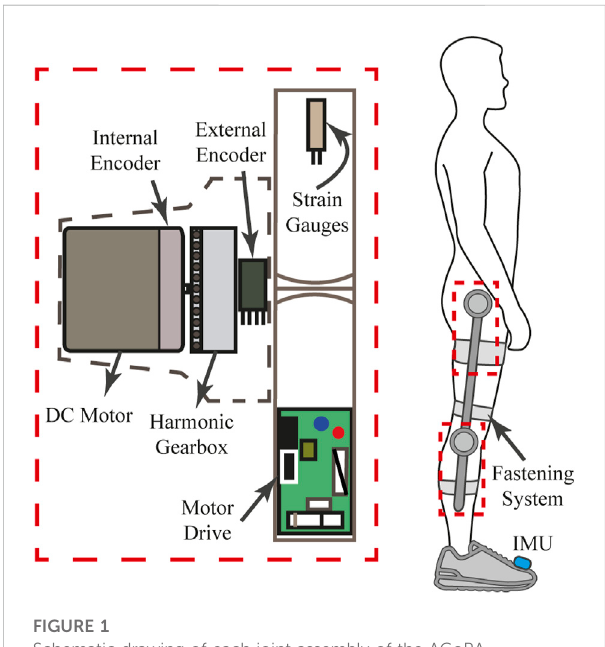
FIGURE 1 Schematic drawing of each joint assembly of the AGoRA